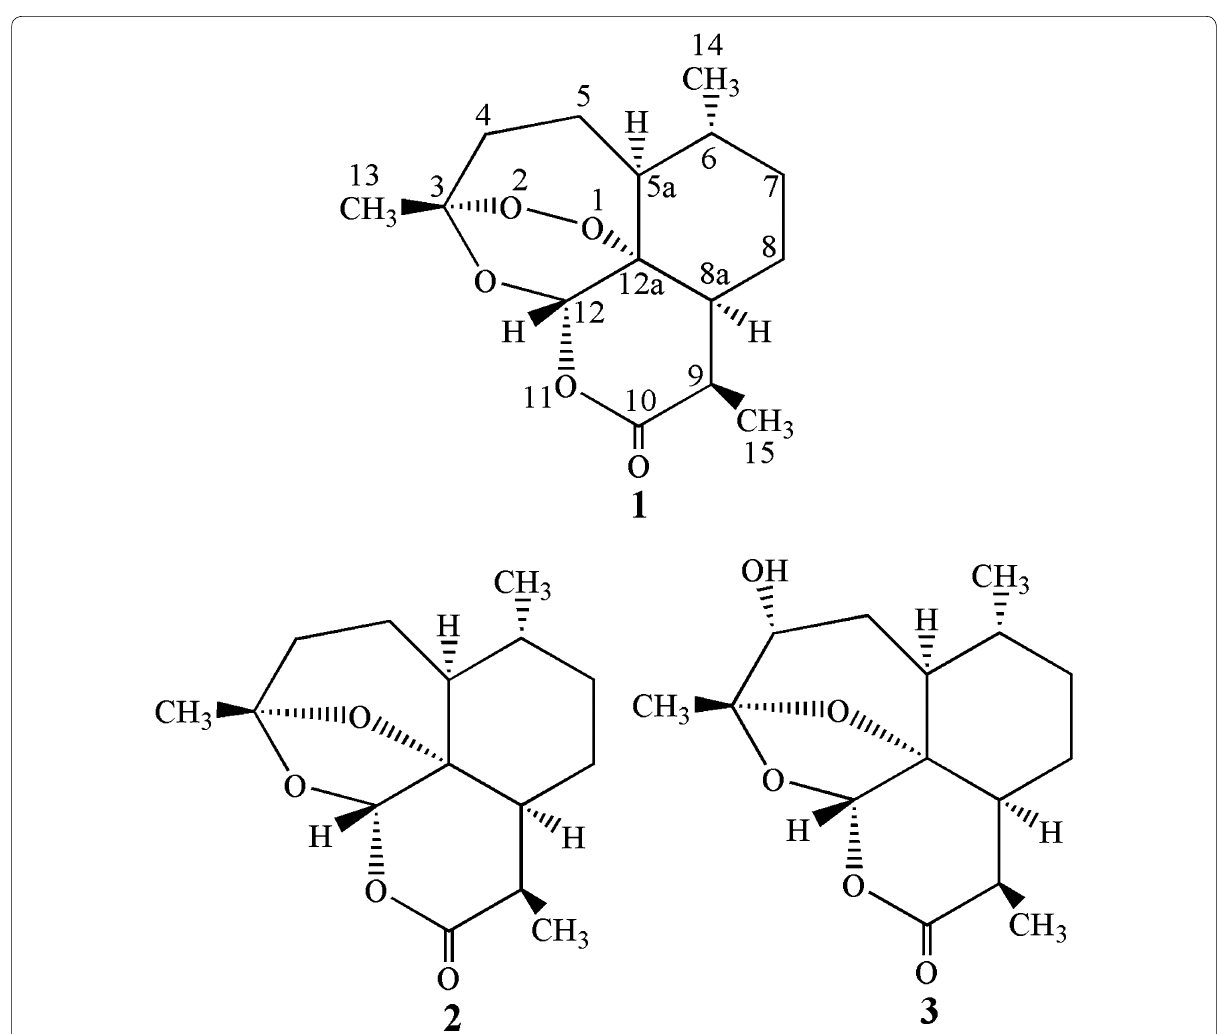
Fig. 1 Structures of artemisinin and two products from microbial transformation of artemisinin by Aspergillus